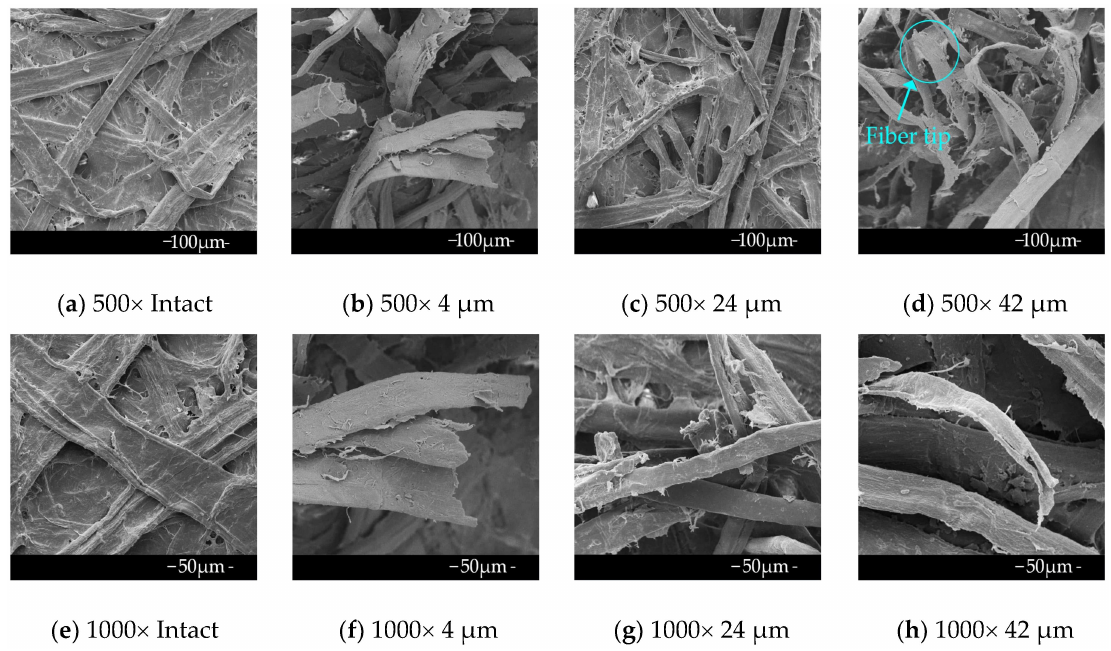
Figure 11. The microstructure of white marks on pressboards under different